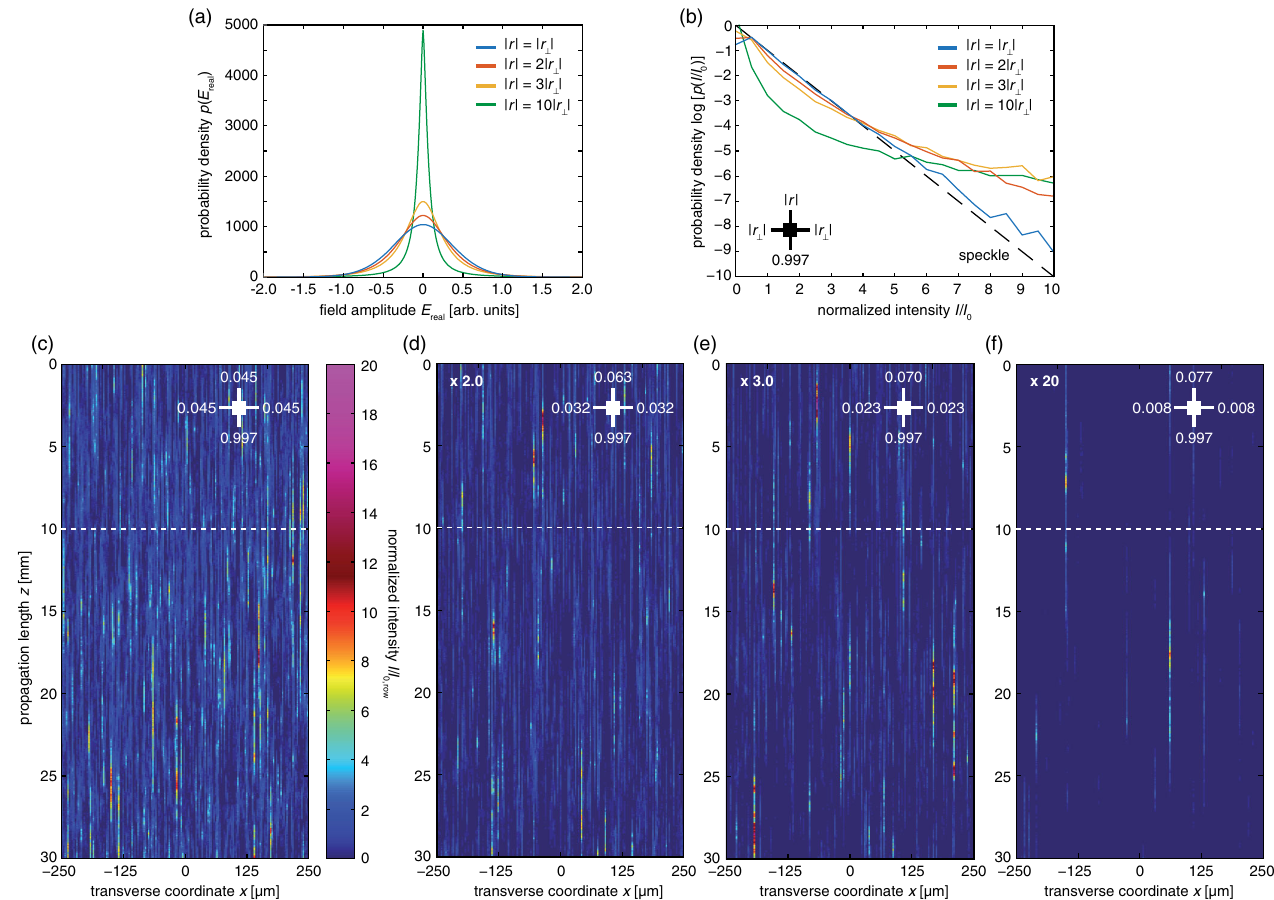
FIG. 8. Field and intensity statistics of the cavity modes for the big domain ( N L ¼ 1500 , N W ¼ 501 ). (a) Probability density functions, i.e., relative frequencies of the real valued field amplitudes over the whole spatial domain for an ensemble of 256 eigenvectors and varying ratios between the backscattering amplitude j r j and the lateral scattering amplitude j r ⊥ j . For j r j ¼ j r ⊥ j , the statistics of the field amplitudes is Gaussian (blue solid line), for j r j ¼ 2 j r ⊥ j it is sech shaped (red solid line), while for j r j ¼ 10 j r ⊥ j a Laplace distribution evolves (green solid line). (b) Corresponding histogram of the normalized intensity distribution for the 256 eigenvectors evaluated at a propagation length z ¼ 10 mm [see dashed white lines in (c) – (f)]. For prevailing backscattering the probability distribution increasingly differs from a speckle distribution (black dashed line). Exemplary plots of the intensity distribution of individual eigenvectors, for (c) j r j ¼ j r ⊥ j , (d) j r j ¼ 2 j r ⊥ j , (e) j r j ¼ 3 j r ⊥ j , and (f) j r j ¼ 10 j r ⊥ j . Note that in (d) – (f) the intensities have been divided by 2, 3, and 20, respectively, to comply with the color bar. Scarlike patterns aligned along the propagation direction of light can be seen in all four cases, but the contrast to the background changes